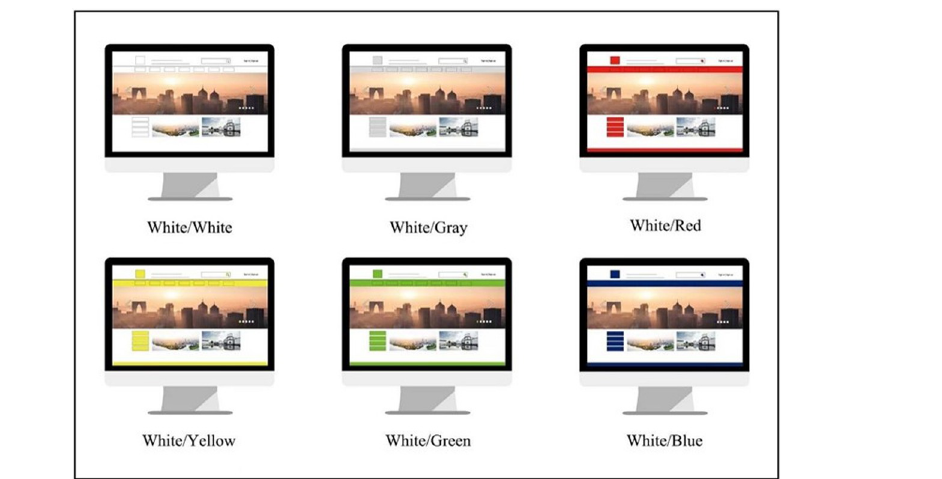
Fig 3. Color map of the multimedia portal website.